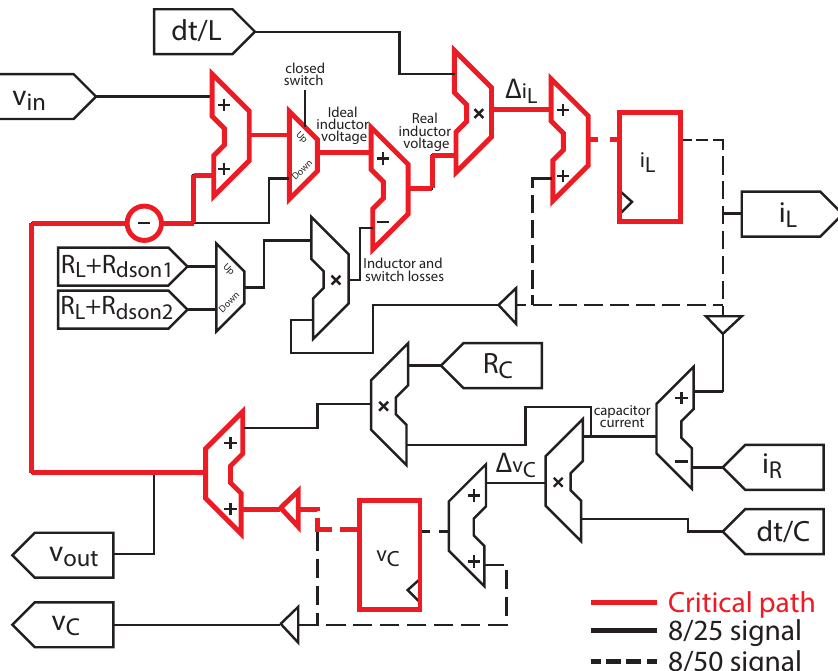
Figure 7. Schematic of a synchronous buck converter with electrical